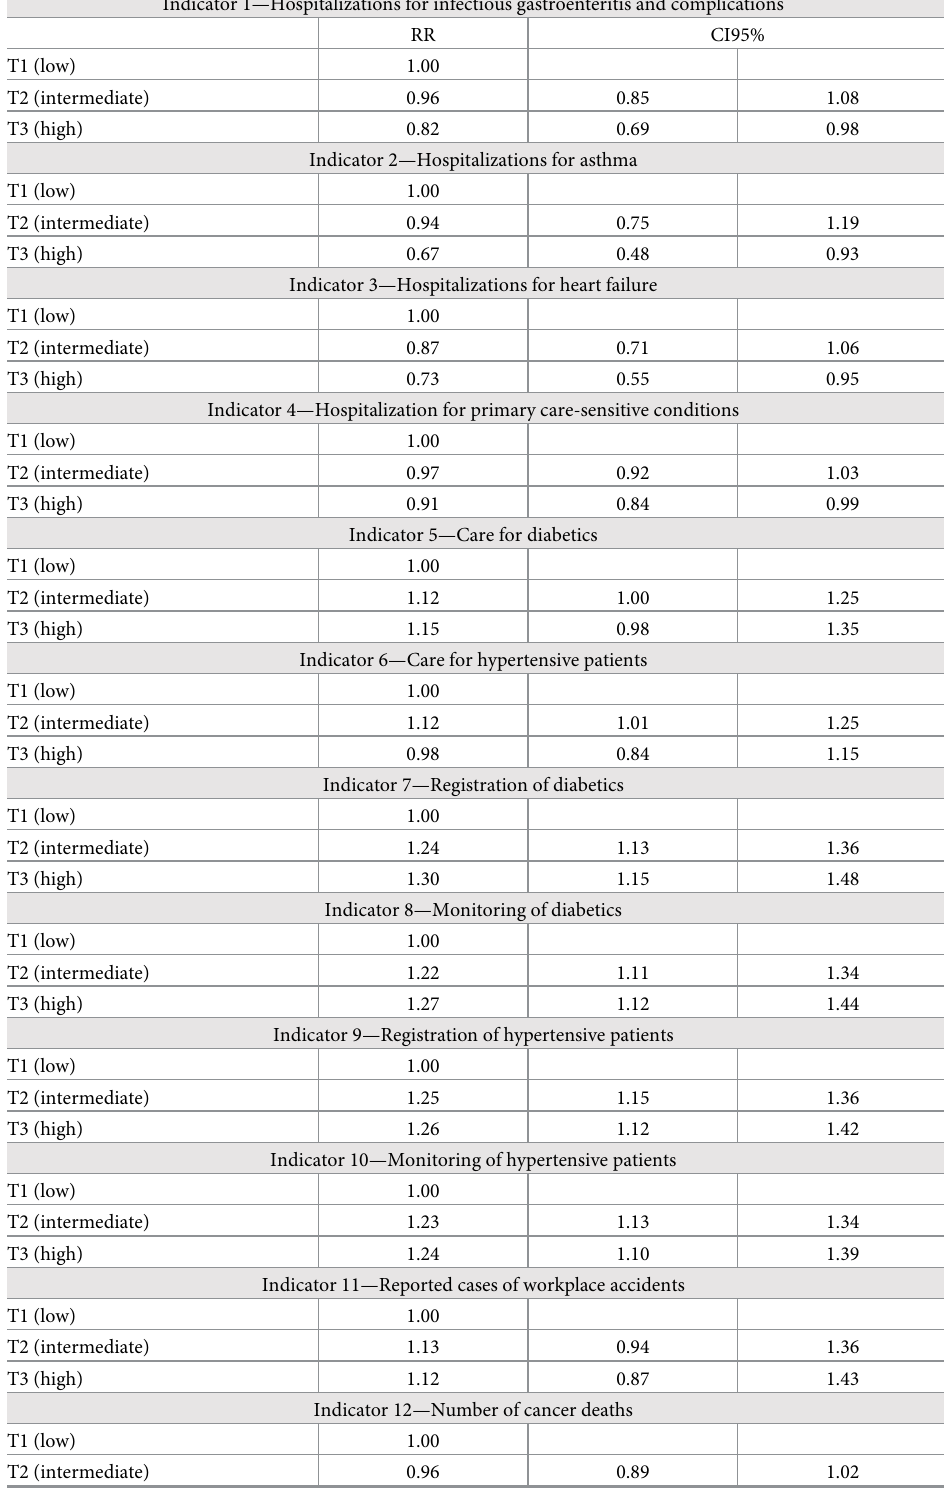
Table 2. Indicators related to hospitalizations for primary care-sensitive causes (Mato Grosso do Sul, 2009–2015). Indicator 1—Hospitalizations for infectious gastroenteritis and